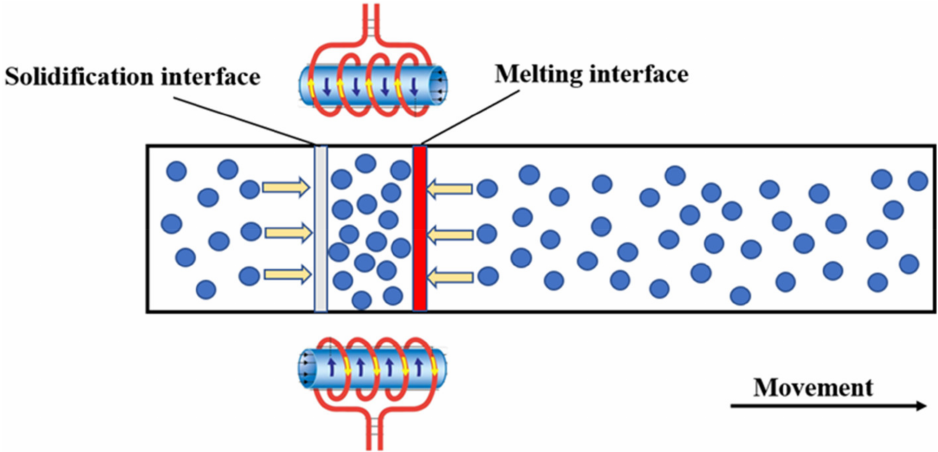
Figure 12. Impurity backflow